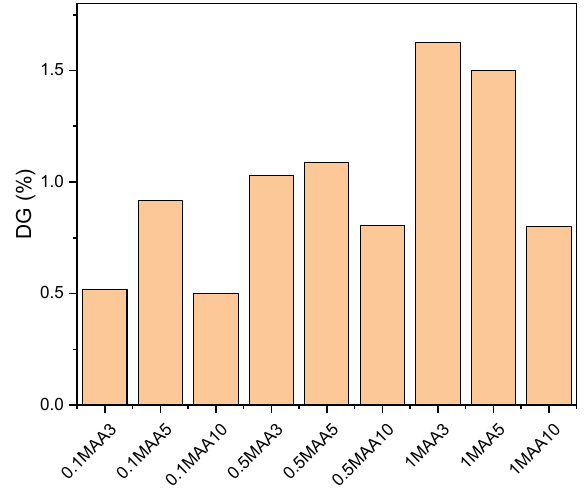
Figure 7. Degree of grafting of the modified membranes.